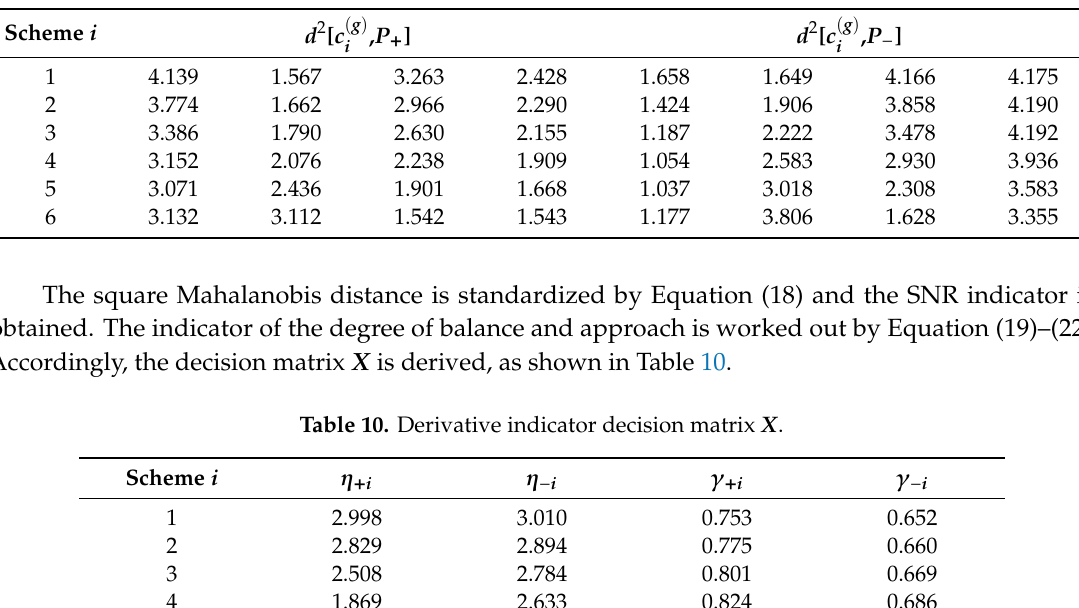
Table 9. Square Mahalanobis distance.